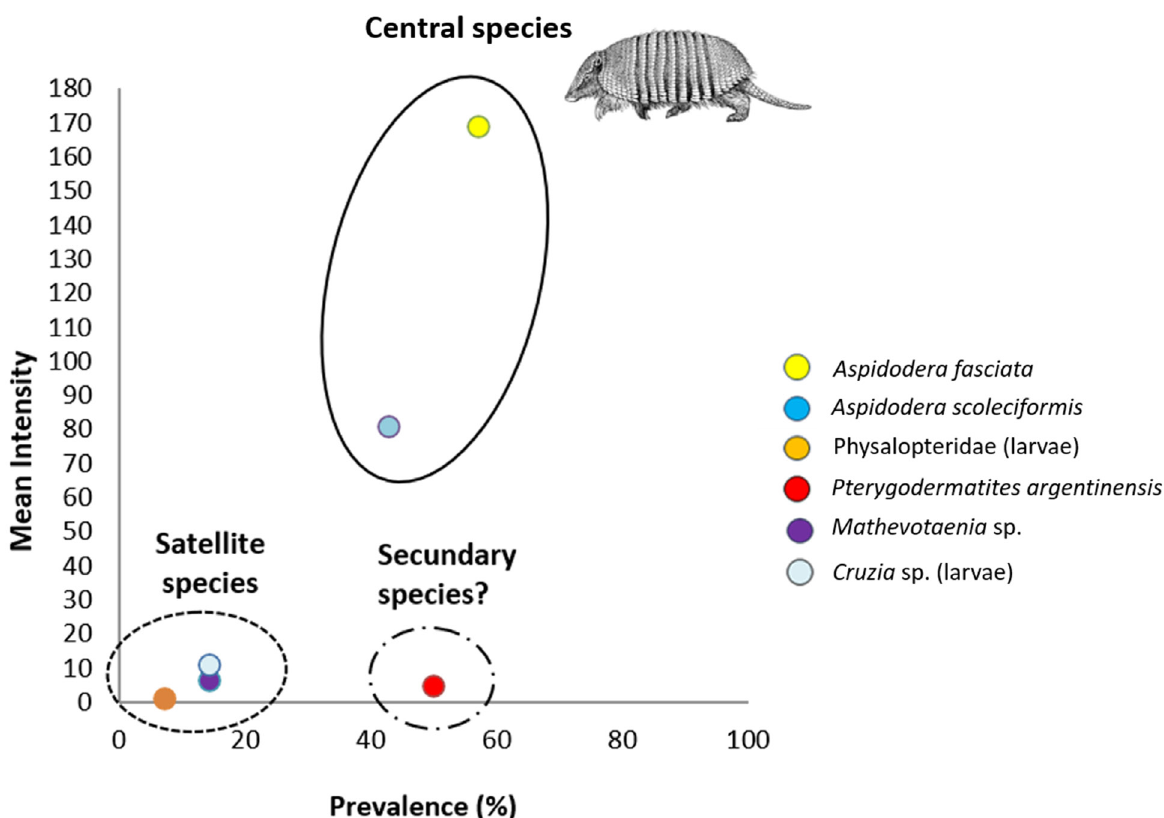
Figure 2. Community structure of helminthes of Zaedyus pichiy in Patagonia. Illustration modified from Díaz & Barquez